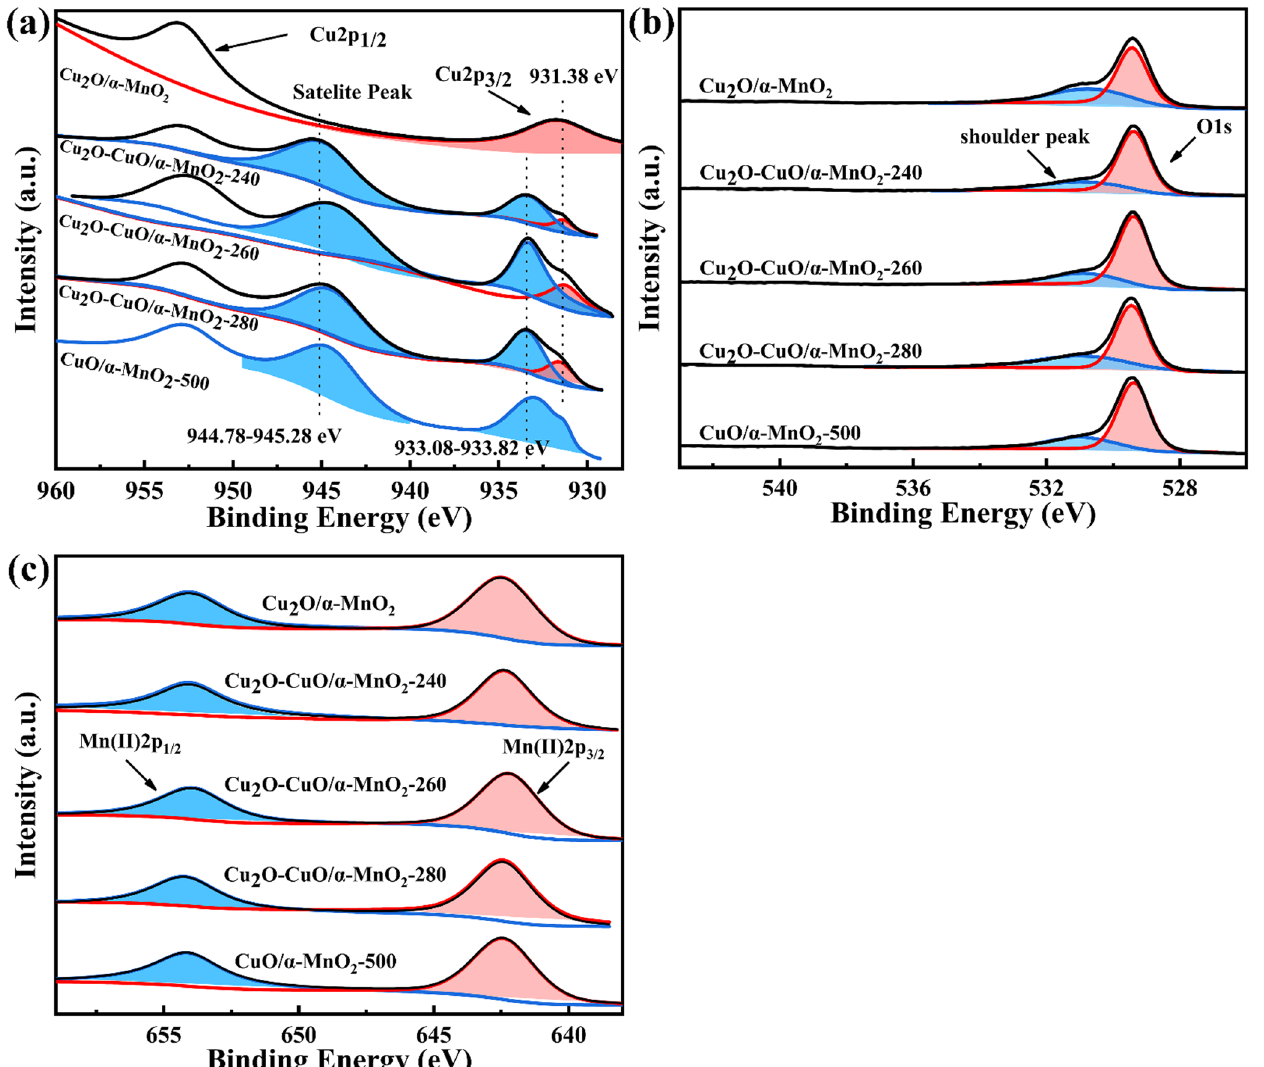
Figure 12. ( a ) Cu 2p, ( b ) O 1s, and ( c ) Mn 2p XPS spectra of the as-prepared Cu 2 O/ α -MnO 2 , Cu 2 O-CuO/ α -MnO 2 -T, and CuO/ α -MnO 2 -500 catalysts. Table 3. O 1s peak area of the as-prepared Cu 2 O/S (S = ZSM-5, CeO 2 , α -MnO 2 , and Fe 2 O 3 )